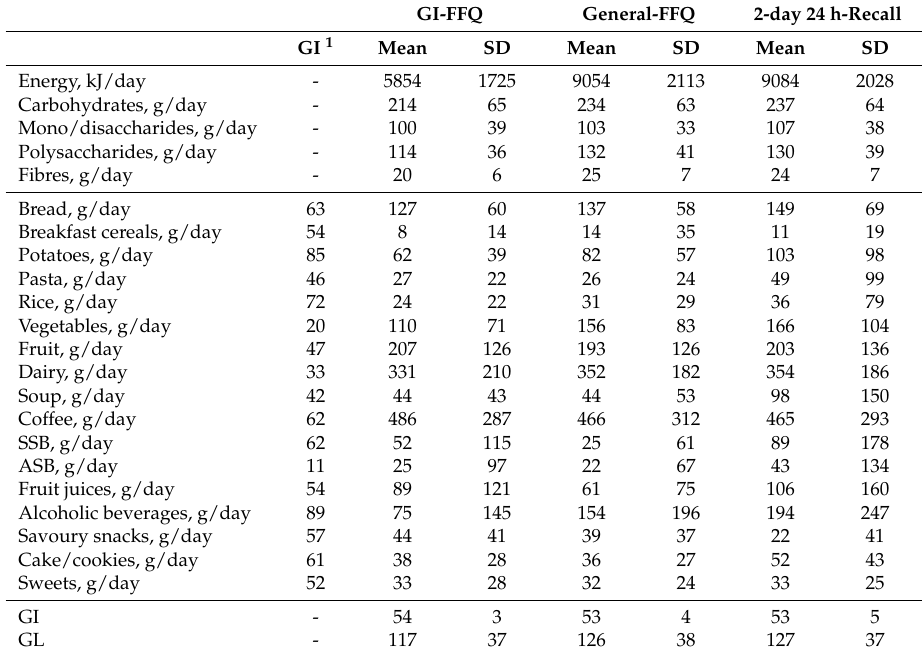
Table 2. Absolute intakes of nutrients, foods, glycaemic index (GI) and glycaemic load (GL) as